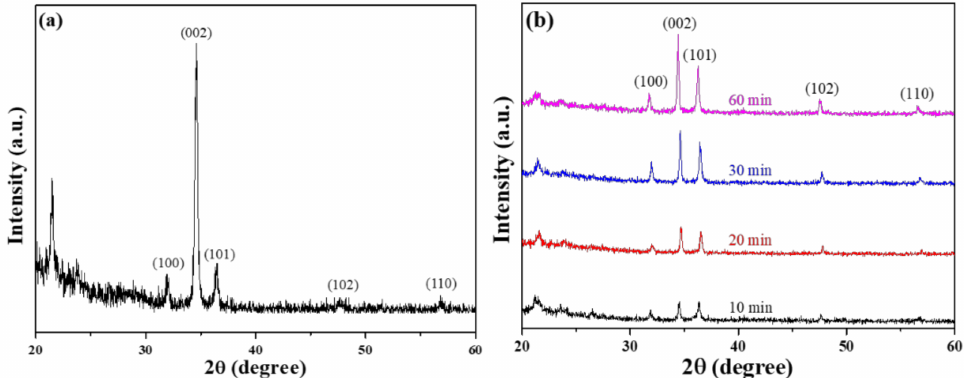
Figure 2. XRD patterns of ( a ) prepared ZnO seed layer and ( b ) different-time-synthesized ZnO